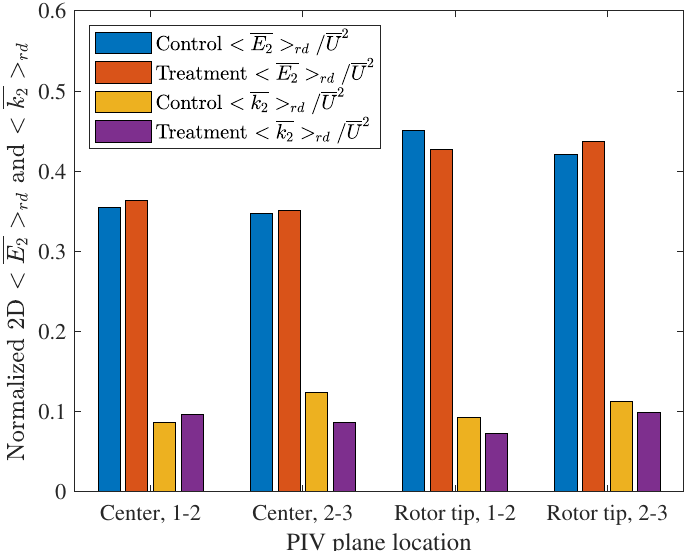
Figure 13. Comparisons between control and treatment of the spatially and temporally averaged mean and turbulent kinetic energies at each PIV measurement location. Note that these have been calculated using only the two-dimensional data in the PIV plane.